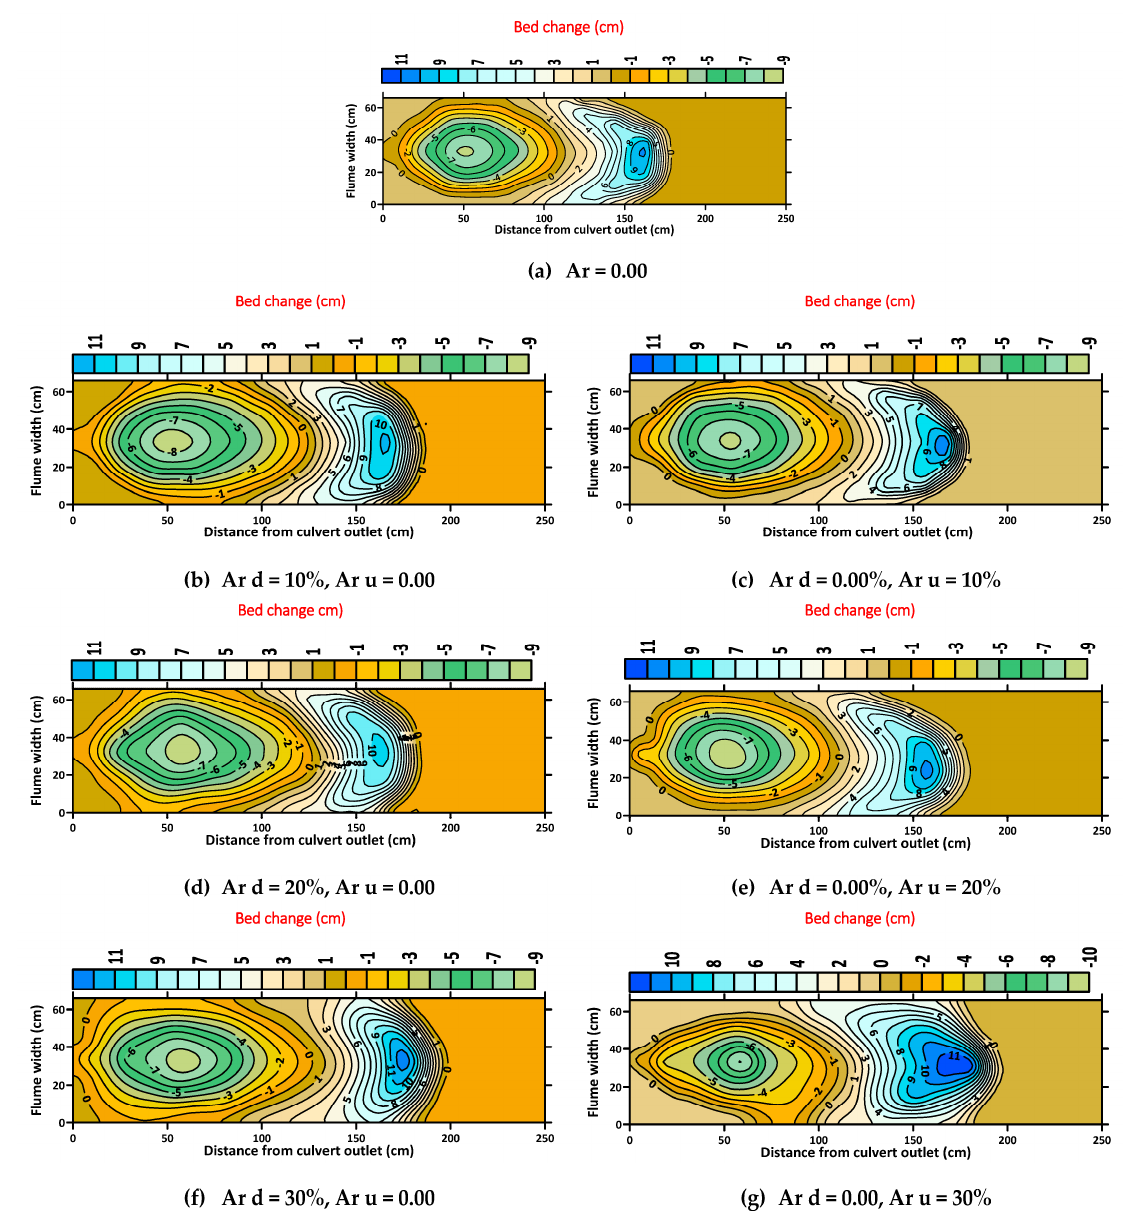
Figure 11. Scour contour maps downstream of blocked circular culvert at S = 1.06 ( a ) Ar = 0.00, ( b ) Ar d = 10%, Ar u = 0.0 ( c ) Ar d = 0.0, Ar u = 10% ( d ) Ar d = 20%, Ar u = 0.0 ( e ) Ar d = 0.00%, Ar u = 20%